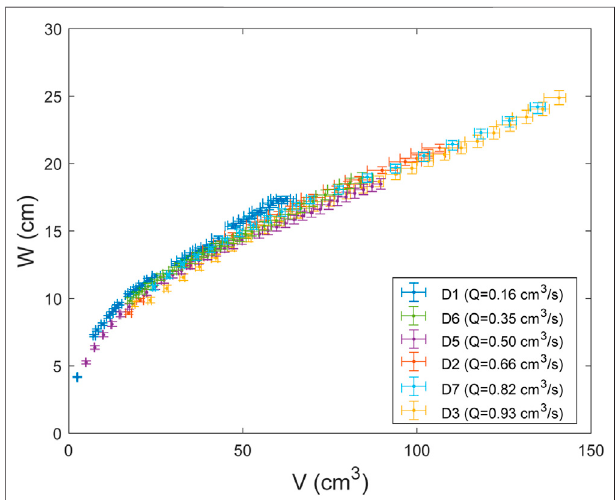
FIGURE 5 | Variation of the dike width with the intruded volume (V). D1, D2, D3, D5, D6, D7 point respectively Experiments 1, 2, 3, 5, 6,